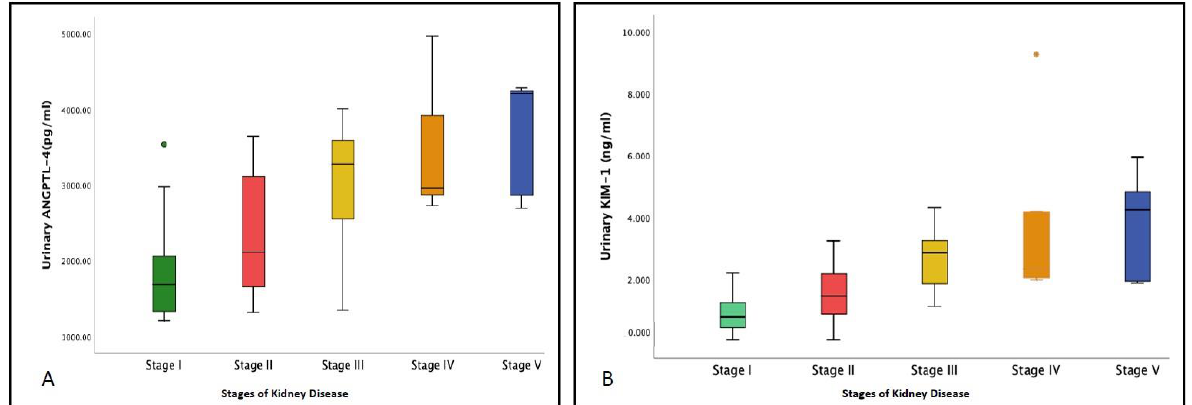
Figure 4. Urinary levels of the biomarkers ( A ) ANGPTL-4 and ( B ) KIM-1 in the patients classified on the basis of estimated glomerular filtration rate (eGFR) values into stage I CKD (eGFR > 90 mL/min/1.73 m 2 ), stage II CKD (eGFR: 60–89 mL/min/1.73 m 2 ), stage III CKD (eGFR: 30–59 mL/min/1.73 m 2 ), stage IV CKD (eGFR: 15–29 mL/min/1.73 m 2 ), and stage V CKD (eGFR < 15